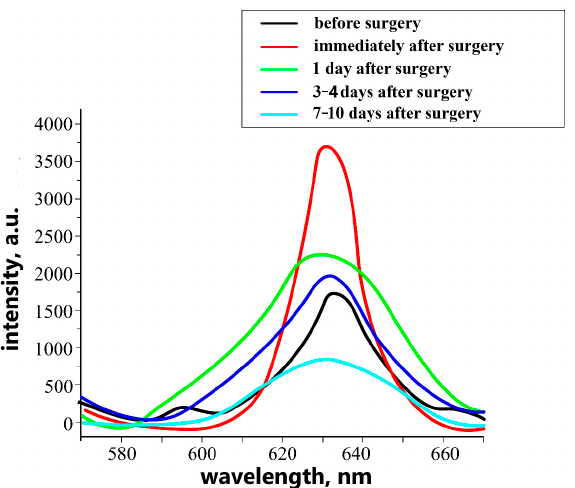
Figure 1. Dependence of the luminescence intensity of Protoporphyrin IX on the dynamics of the development of inflammatory processes as a result of implantation. 4. Conclusions The use of the luminescent diagnostics method for the oral fluid using the hardware- software complex “EnSpectr M” with a laser radiation wavelength of 405 nm allows for the determination of the severity of inflammation markers (Protoporphyrin IX), taking into account the individualization of the clinical case. For the first time, the diagnostic criteria allowed the possibility of predicting the development of an inflammatory process after intraosseous implantation and the ability to plan an individualized complex to pre- vent the development of complications after dental implantation. When comparing the method of luminescence spectroscopy with index methods (PI, PMA), it was possible to draw conclusions from numerical values, while the index meth- ods were accompanied by an approximate visual assessment. When comparing lumines- cent diagnostics with a bioimpedance analyzer, laser-Doppler flowmetry capillaroscopy, the advantage was the absence of the need for contact with the tissues of the postoperative area and the possibility of the specific detection of an inflammation marker. Author Contributions: Conceptualization, D.V.P., V.I.K. and V.F.P.; methodology, D.V.P. and V.I.K.; formal analysis, D.V.P. and V.I.K.; writing—original draft preparation, D.V.P., V.I.K. and V.F.P.; writing—review and editing, D.V.P., V.I.K. and V.F.P.; project administration, V.I.K. and V.F.P. All authors have read and agreed to the published version of the manuscript. Funding: This research received no external funding. Data Availability Statement: Not applicable. Acknowledgments: The authors are grateful to the Osipyan Institute of Solid State Physics of the Russian Academy of Science (ISSP RAS). Conflicts of Interest: The authors declare no conflict of interest.